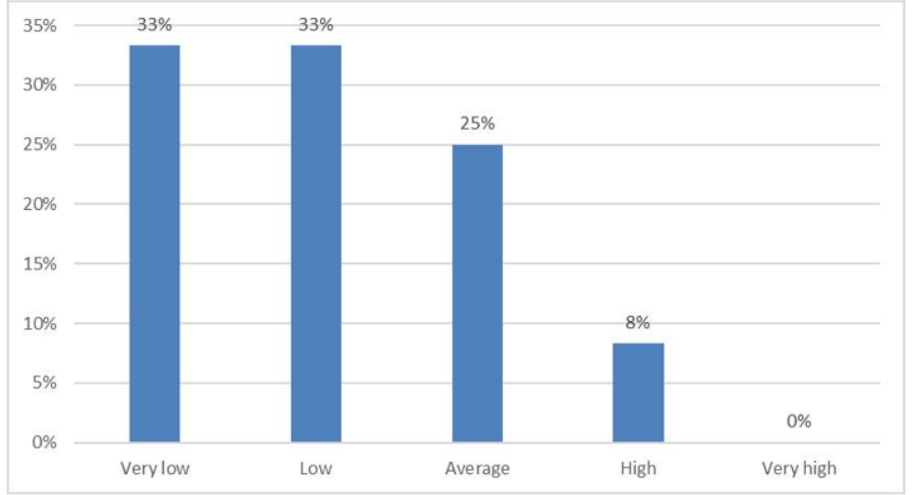
Figure 15. Reductions in Production or Manufacturing Capacities